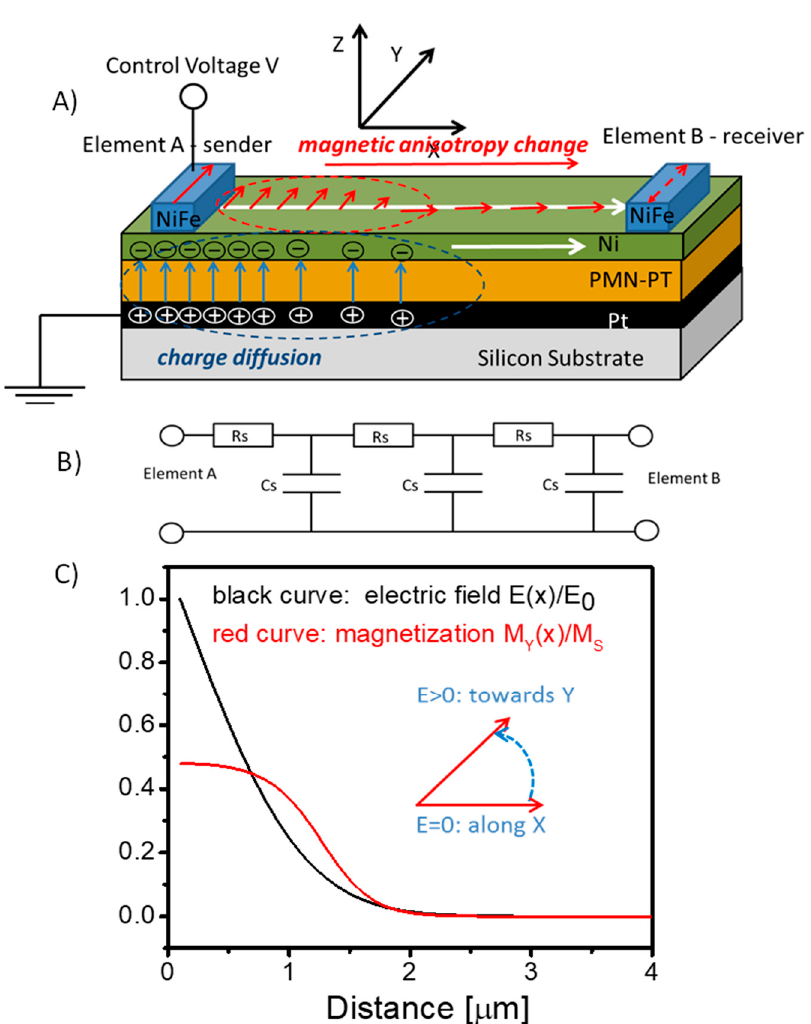
Figure 1. ( A ) Schematics of the synthetic multiferroic interconnect comprising a piezoelectric layer (PMN-PT) and a magnetostrictive layer (Ni). The structure resembles a parallel plate capacitor. An application of voltage at point A results in charge diffusion through the plates. In turn, an electric field applied across the piezoelectric produces stress, which rotates the easy axis of the magnetoelastic material. ( B ) The equivalent electric circuit—RC line, which is used in numerical simulations. ( C ) Results of numerical simulations showing the distribution of the electric field and the magnetization along the interconnect. The change of magnetization in the magnetoelastic layer follows the charge diffusion.